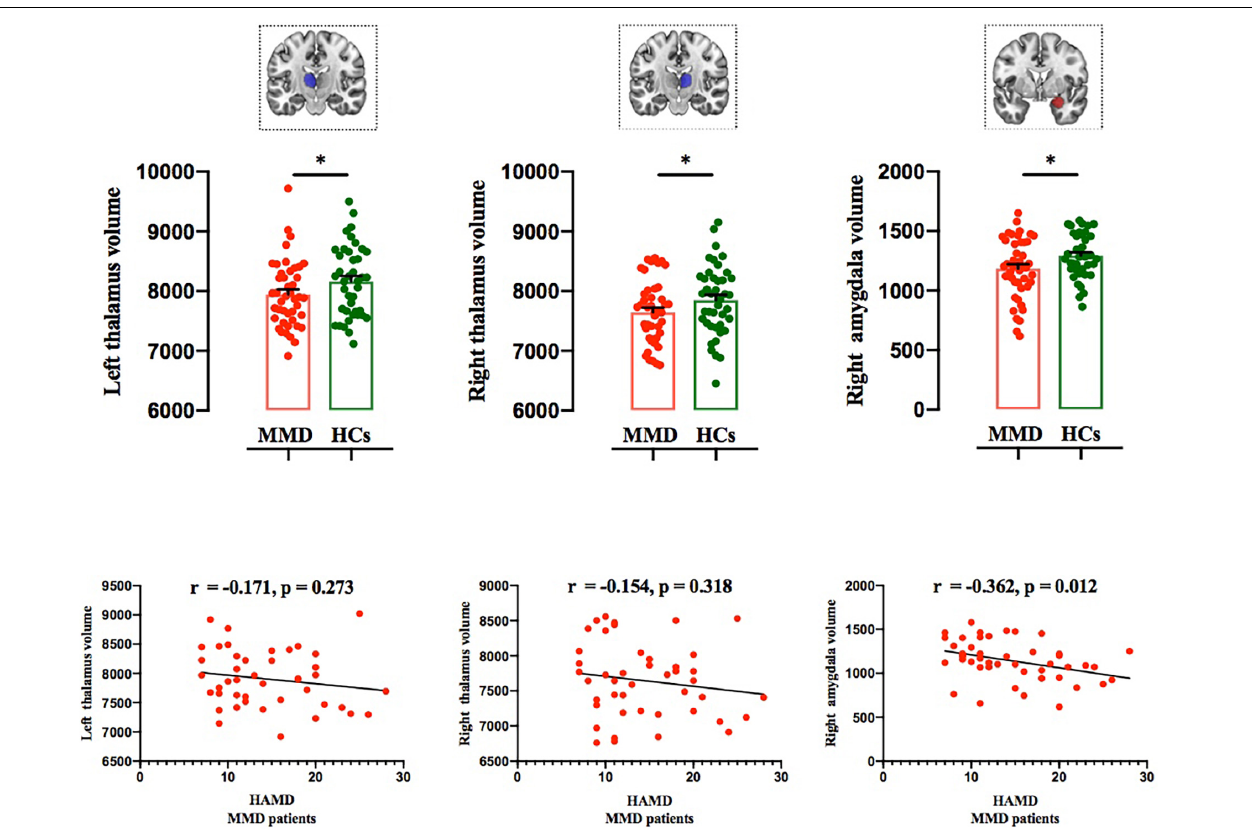
FIGURE 3 | Comparison of subcortical volumes between the two groups, and correlations between subcortical volumes and HAMD scores in MMD patients. Top panel: The gray matter volumes of the left thalamus, right thalamus, and right amygdala were significantly smaller in MMD patients than in HCs ( ∗ p < 0.006; Bonferroni corrected). Bottom panel: Right amygdala volume was significantly negatively correlated with HAMD score, whereas the left and thalamus volumes were not related to HAMD score in MMD patients. MMD, mild-to-moderate depression; HCs, Healthy Controls. TABLE 3 | Clusters that exhibited significant resting-state functional connectivity differences of right amygdala between mild-to-moderate depression (MMD) patients and healthy controls.